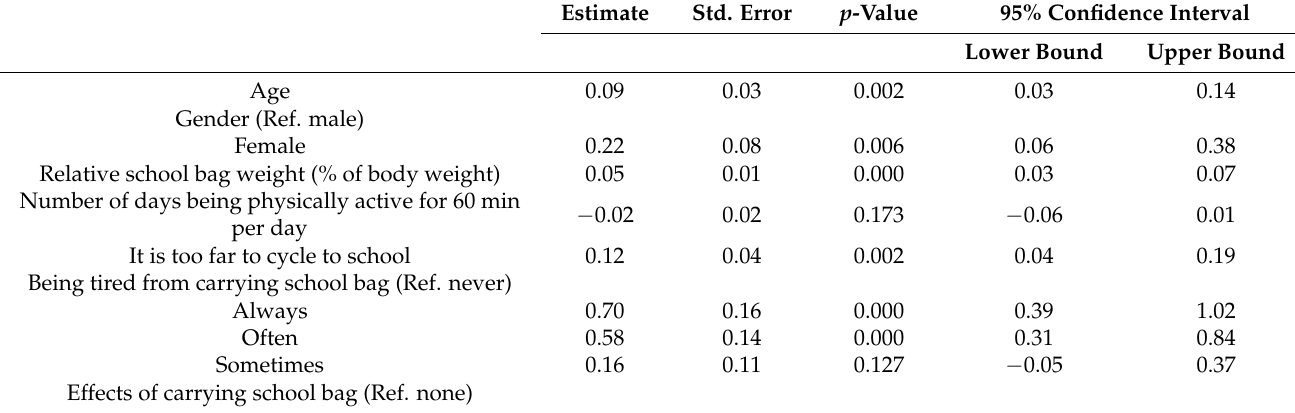
Table 5. Multivariate correlates of adolescents’ perceptions that their school bag is too heavy for cycling to school.